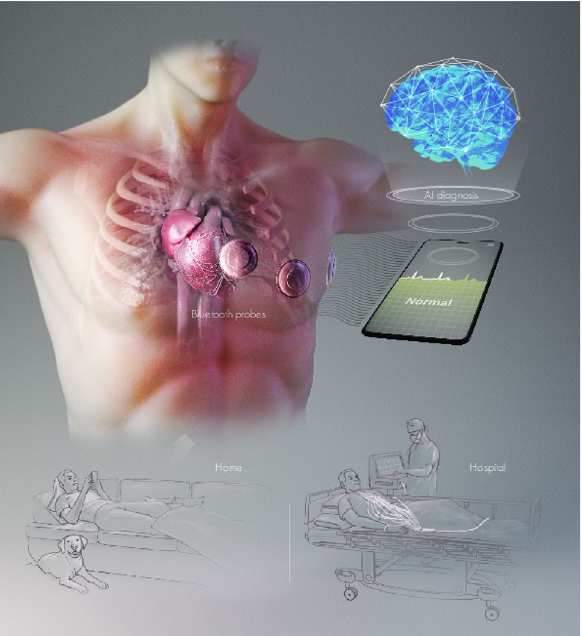
Figure 2. A cardiologist- and probe-less contemporary cardiovascular disease diagnosis system. Authors are thankful for the illustration created by Ivan Gromicho. Scientific Illustrator at Research Communication and Publication Services. Office of the Vice President for Research—King Abdullah University of Science and